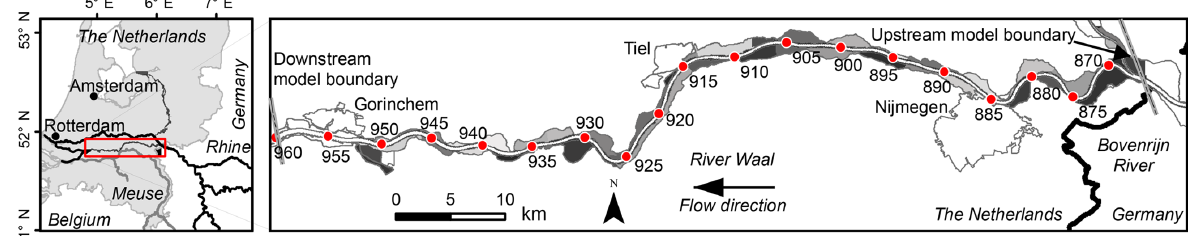
Figure 1. The river Waal, a river reach 85km long between the Pannerden bifurcation near the Dutch–German border and Gorinchem, upstream of significant tidal influence. The center of the study area is located at 51 ◦ 53 (cid:48) N and 5 ◦ 37 (cid:48) E. The greyscale differences show the 94 individual floodplain